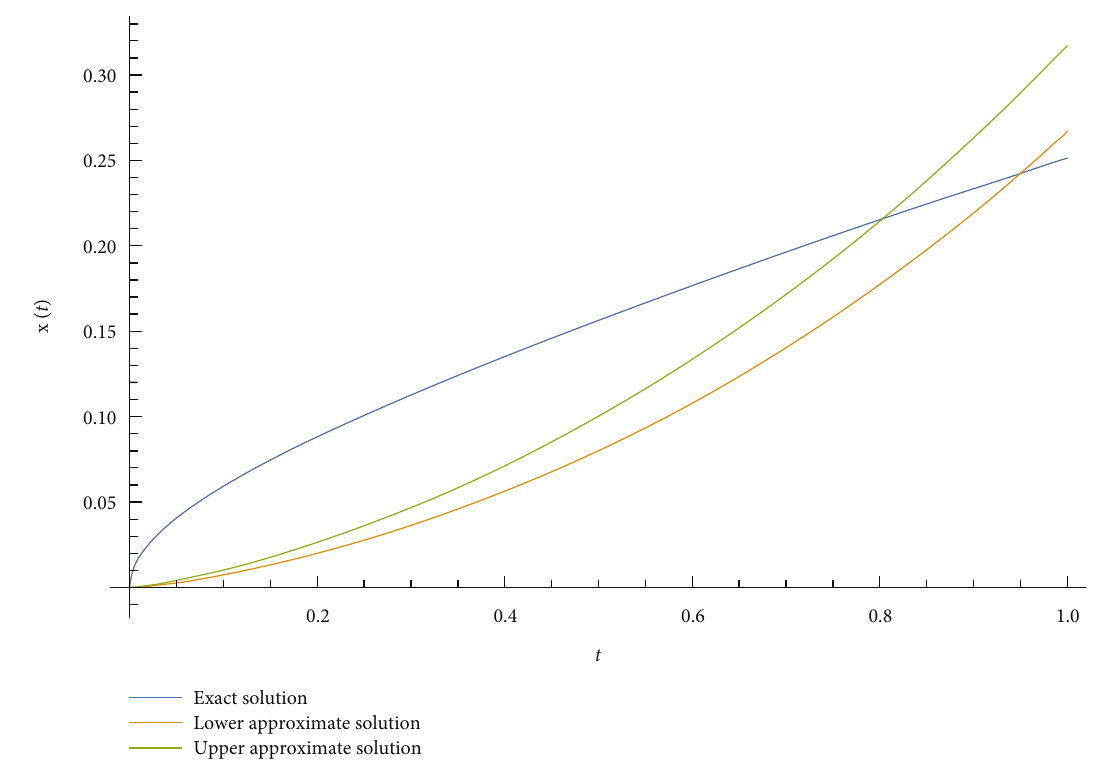
Figure 1: Exact solution with approximate solution F 1